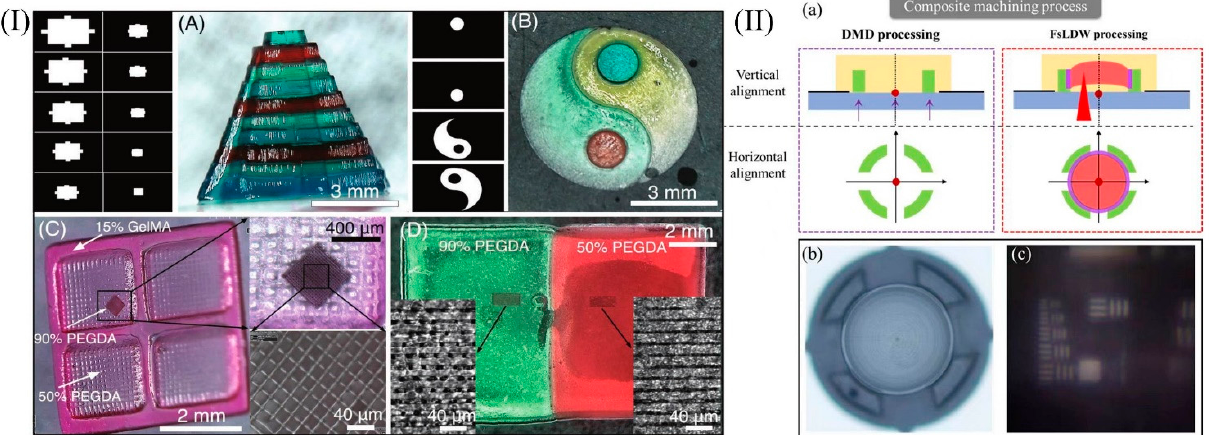
Figure 9. The structure processed using HLP technology is shown in ( A – D ) in ( I ). Samples prepared by our group using DMD and femtosecond laser composite processing technology are shown in ( II ). ( I ) Reprinted with permission from ref. [103].